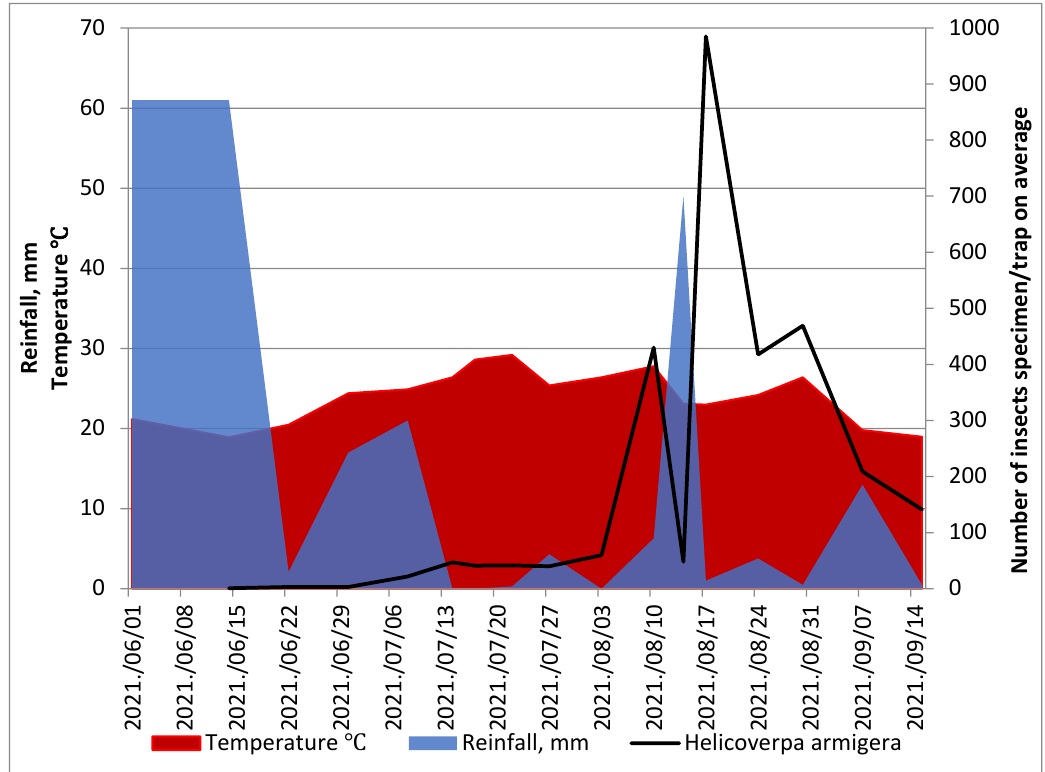
Figure 3. Dependence of the dynamics of the summer of the cotton bollworm on climatic factors. Central zone of Krasnodar Krai. 2021. Figure 4 presents data on both the summer dynamics of all attracted of the insects and the nutmeg moth according to three light traps on average with the values of the confidence interval.